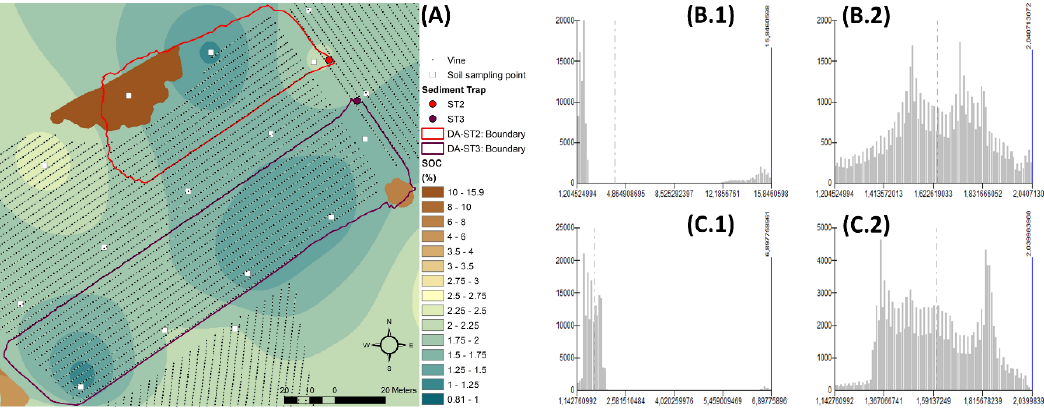
Figure 5. Map of the soil organic matter content ( A ) and corresponding histograms of the DA-ST2 ( B ) and DA-ST3 ( C ) in the total drainage area ( B.1 and C.1 ) and within the vineyard ( B.2 and C.2 ). Table 3. Physical and chemical soil parameters in the drainage area of the two sediment traps. Sub-basin BD Vol eff Clay Texture